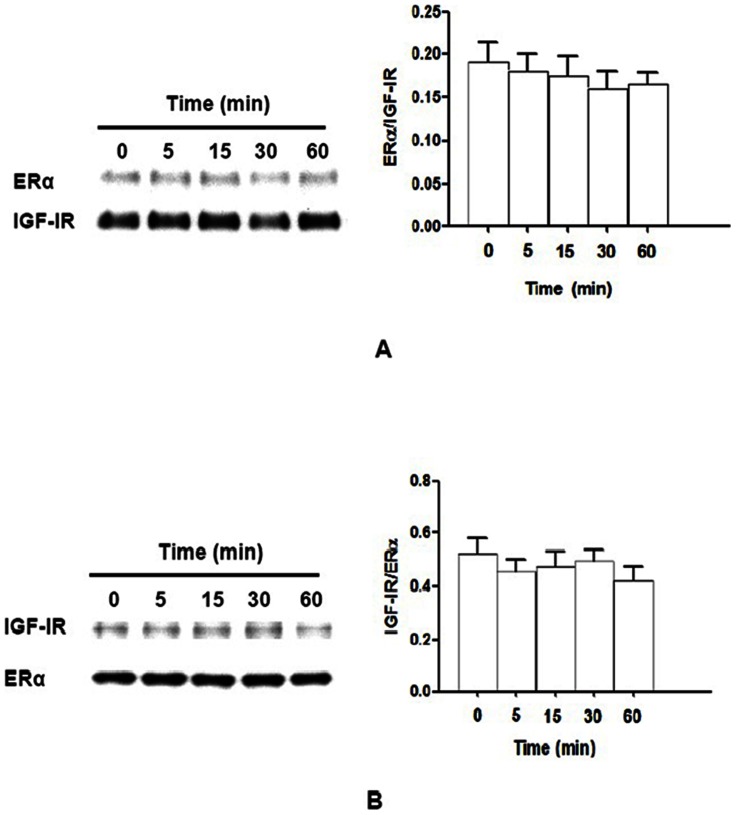
Binding IGF-IR to ERα is abrogated by IGF-I in MCF-7SX13 cells.MCF-7SX13 cells were stimulated with 10 nM IGF-I for 0–60 min. Protein lysates were subjected to immunoprecipitation with IGF-IR (A) or ERα (B) antibodies with subsequent immunoblotting of the precipitated fraction with ERα antibody (A) or IGF-IR antibody (B), respectively. The ratios of ERα/IGF-IR and IGF-IR/ERα at different time points were similar to each other, N = 3, P>0.05.